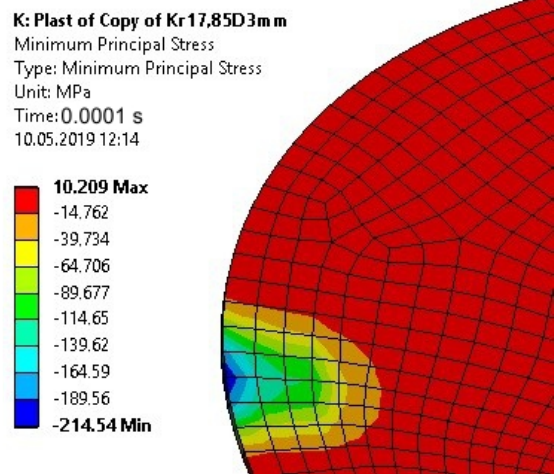
Figure 20. The Minimum Principal Stress in the adhesive joint for a 0.0001 s calculation time after taking into account the plastic properties of the upper element—Model no. 2 (nonlinear analysis).